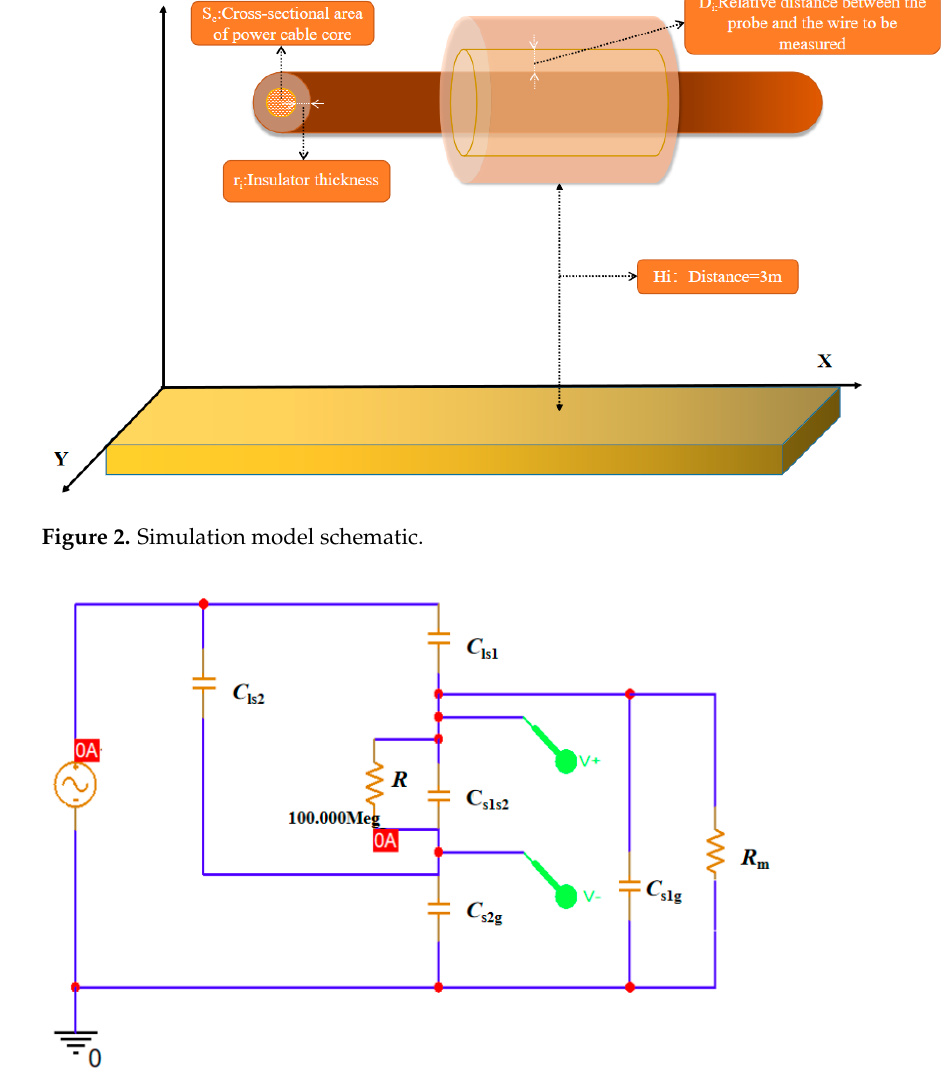
300.76 Table 3. Change the radius of the measurement conductor. Parameters 296.71 Table 4. Change the position of the measurement conductor with respect to the probe. Parameters